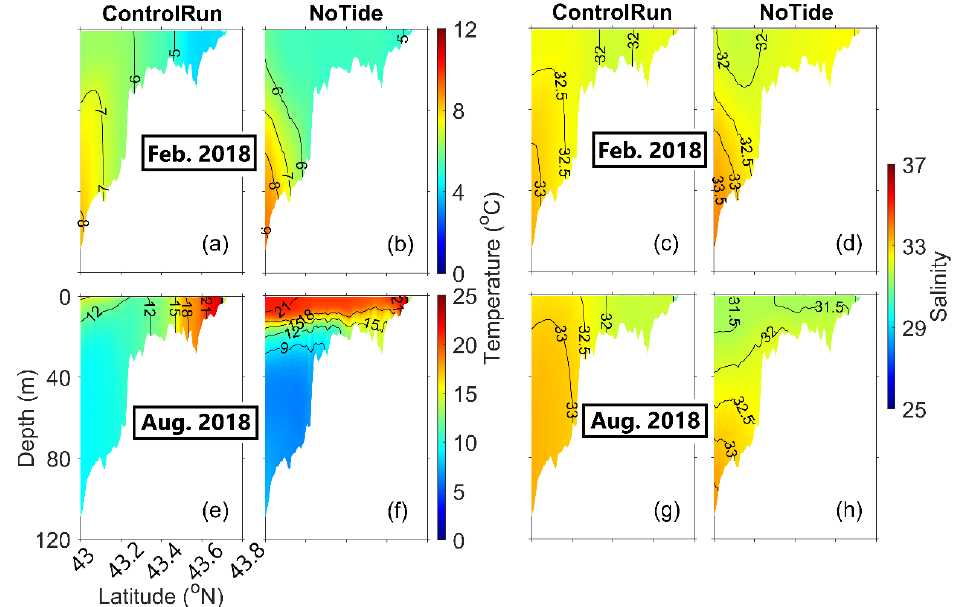
Figure 17. Vertical distributions of monthly-mean ( a , b , e , f ) temperature and ( c , d , g , h ) salinity in ( a – d ) February and ( e – h ) August 2018 along transect EE’ (shown in Figure 1c) simulated by submodel L2 in ( a , c , e , g ) case CR and ( b , d , f , h ) case NT. To quantify the effects of tides on the monthly-mean currents over the swScS, we calculate the impact index ( 𝑇 𝑖𝐷 ) of tides at depth 𝐷 based on the L3 model results using the method by Wang et al. [9].